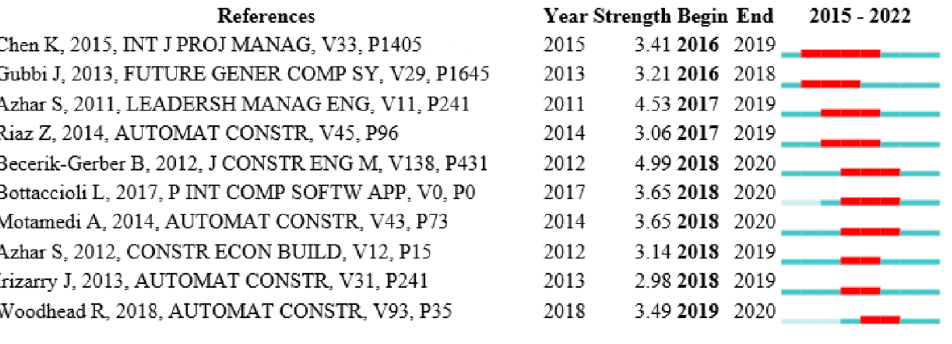
Figure 5. The highest burst literatures of BIM–IoT integration in the WoSc database via Citespace (generated by the authors).